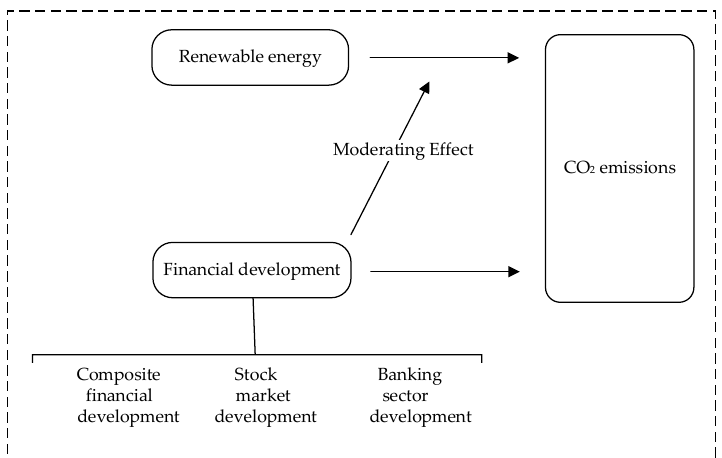
Figure 1. The concept map of this study.